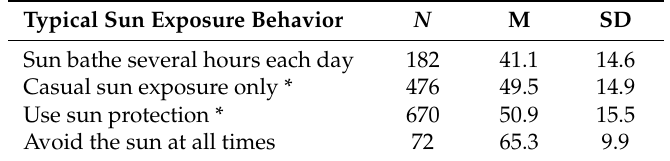
Table 4. Dislike of heat and hot conditions according to typical sun exposure